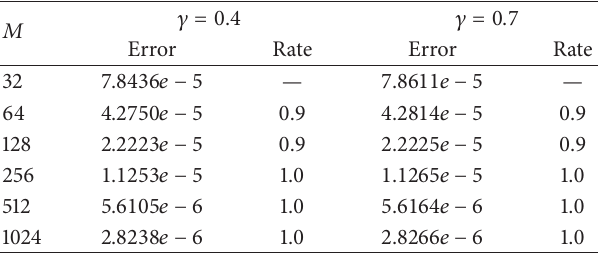
Table 2: Rate for time for 𝑔(𝑥) = 𝑥 𝜇 1 − 𝑥 𝜇 2 with 𝜇 1 = 7/2 , 𝜇 2 = 7/3 for Example 6 using 1st-order